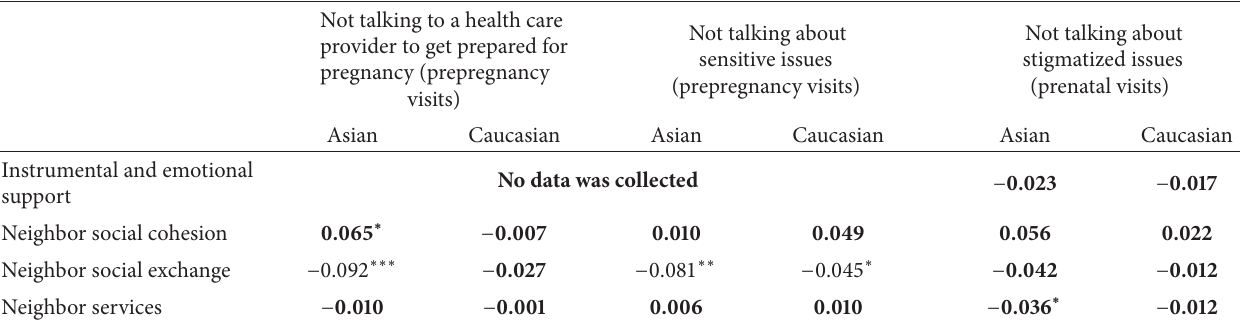
Table 1: Logistic regressions of neighborhood factors in predicting communication during prepregnancy and prenatal visit to health care